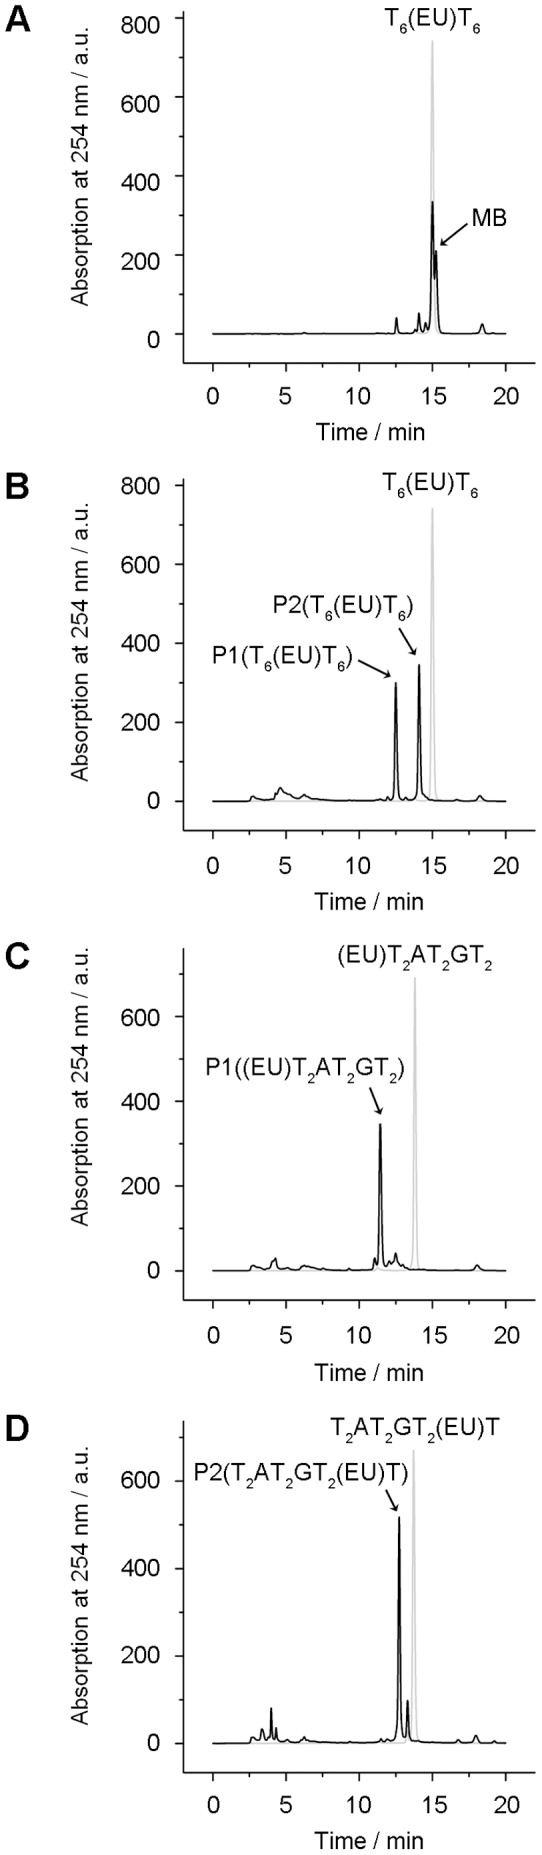
Degradation of DNA oligonucleotides containing 5-ethynyluracil.(A), (B) HPLC charts of T6(EU)T6 before (gray) and after (black) the reaction in 14% NH3aq (A) or 20% MeNH2aq (B) at 70°C for 2 hours. (C), (D) (EU)T2AT2GT2 (C) and T2AT2GT2(EU)T (D) before (gray) and after (black) the reaction in 20% MeNH2aq at 70°C for 2 hours.